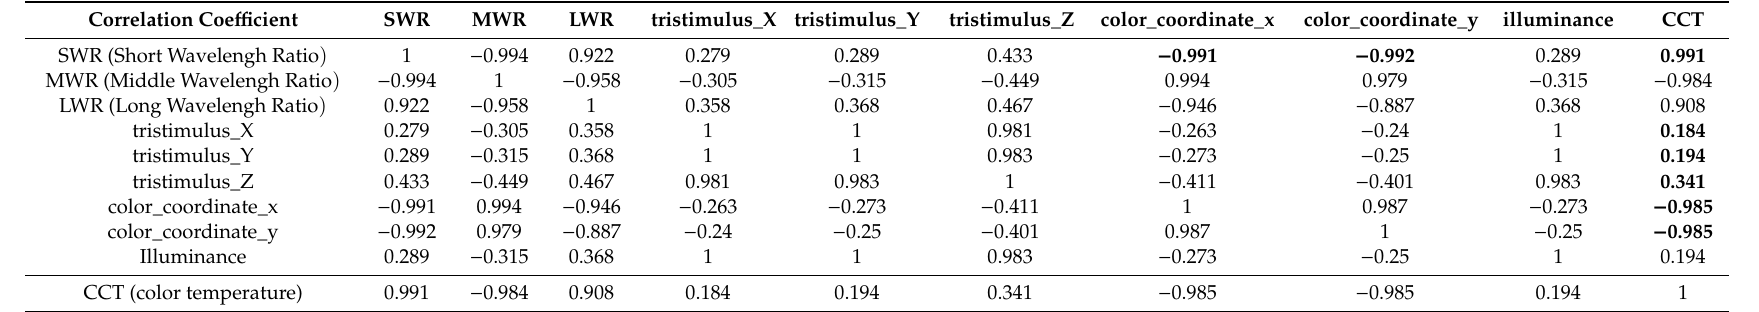
Table 3. Results of analyzing correlatn coe ffi cients among certain factors of natural light: cloudy